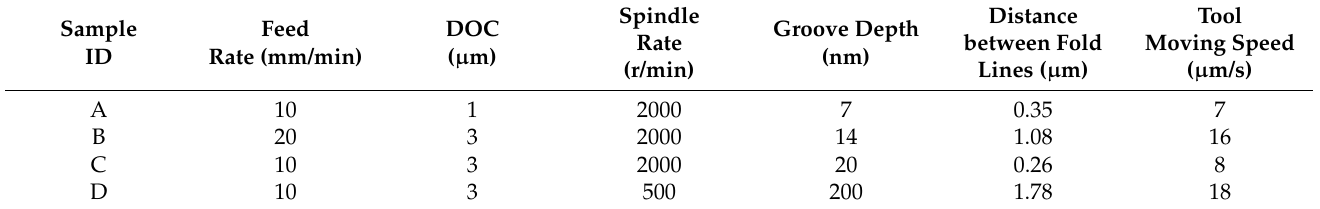
Table 2. BMG machining conditions [109].